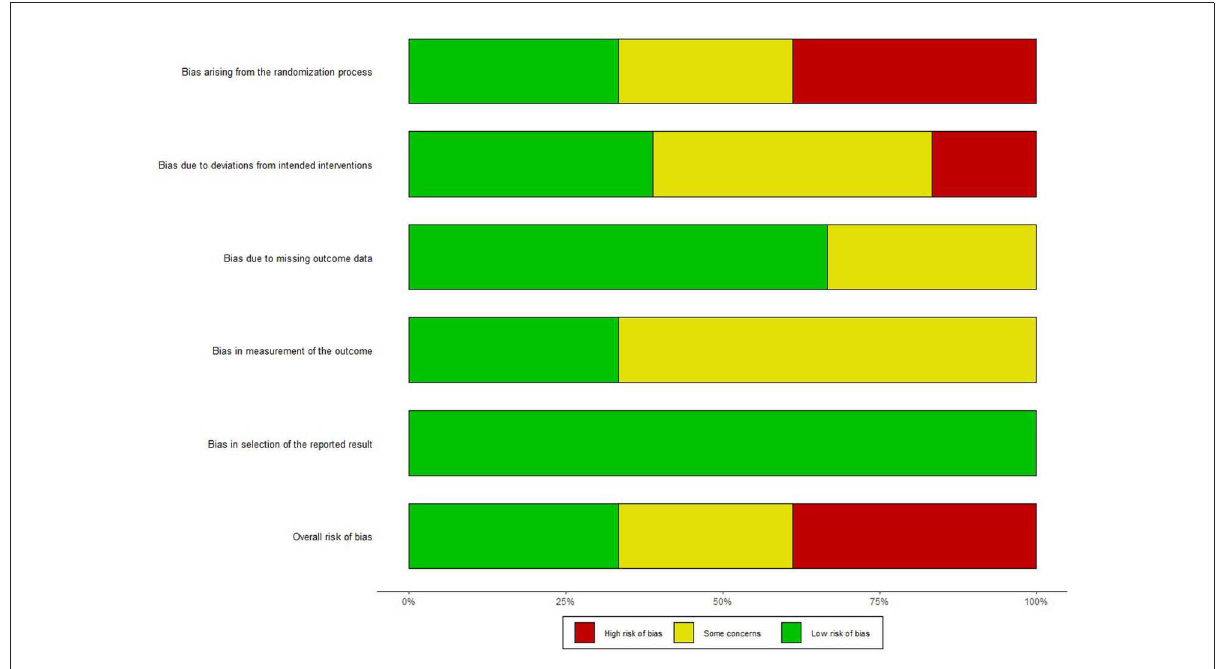
FIGURE2 Risk of bias